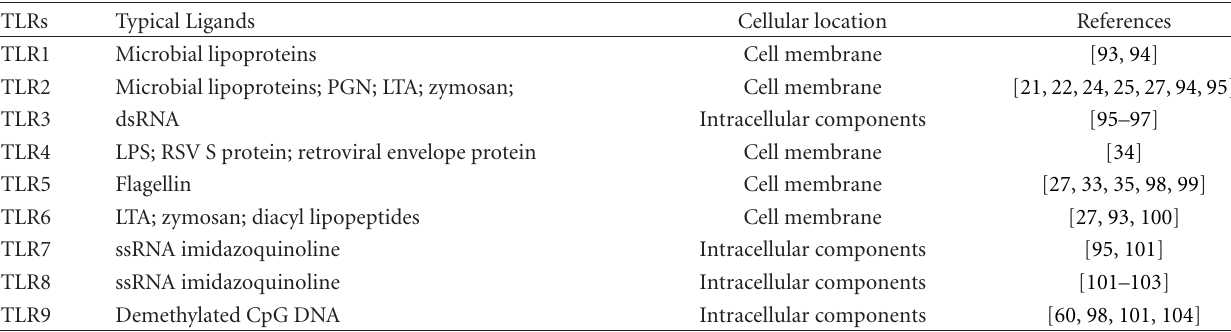
Table 1: Evidenced TLR-related AEC in response to Mtb